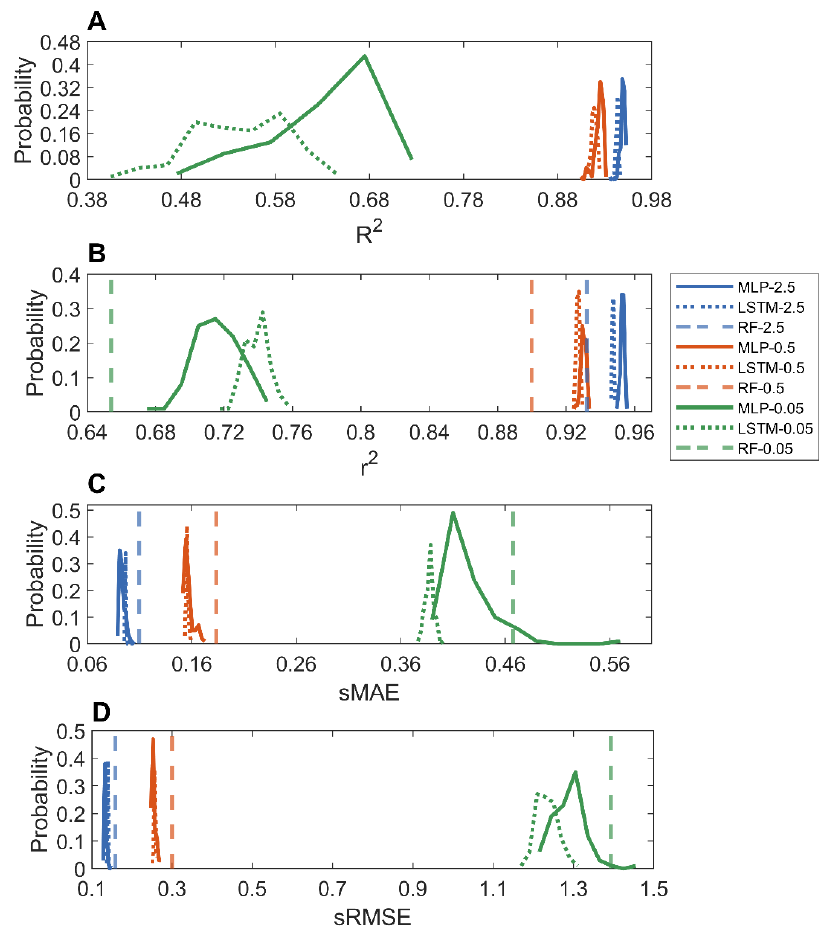
Figure 4. Distributions of performance metrics R 2 ( A ); r 2 ( B ); sMAE ( C ); and sRMSE ( D ) in the 100 holdout validations for MLP (solid curves) and LSTM (dotted curves) models. Pressures of carbon dioxide adsorption predictive models were color coded: green for 0.05 bar, red for 0.5 bar, and blue for 2.5 bar. The x-axis depicts performance metrics marked by the axis label. The reported results of random forest models [36] are shown as vertical lines.